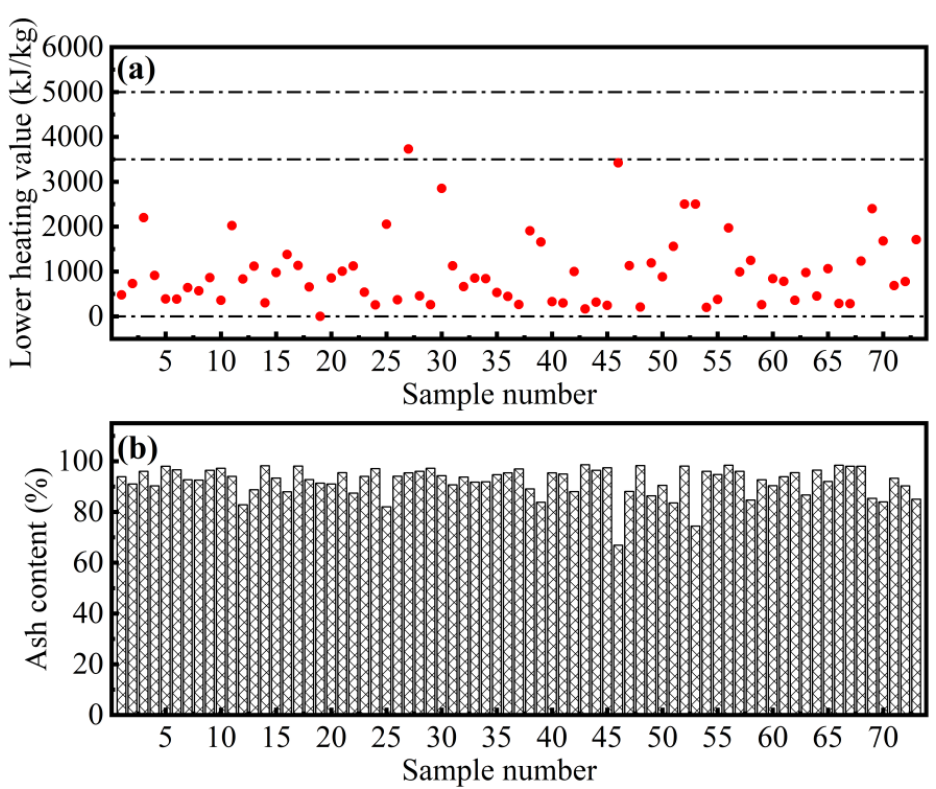
Figure 4. ( a ) LHV and ( b ) ash content of sewer sediment samples.